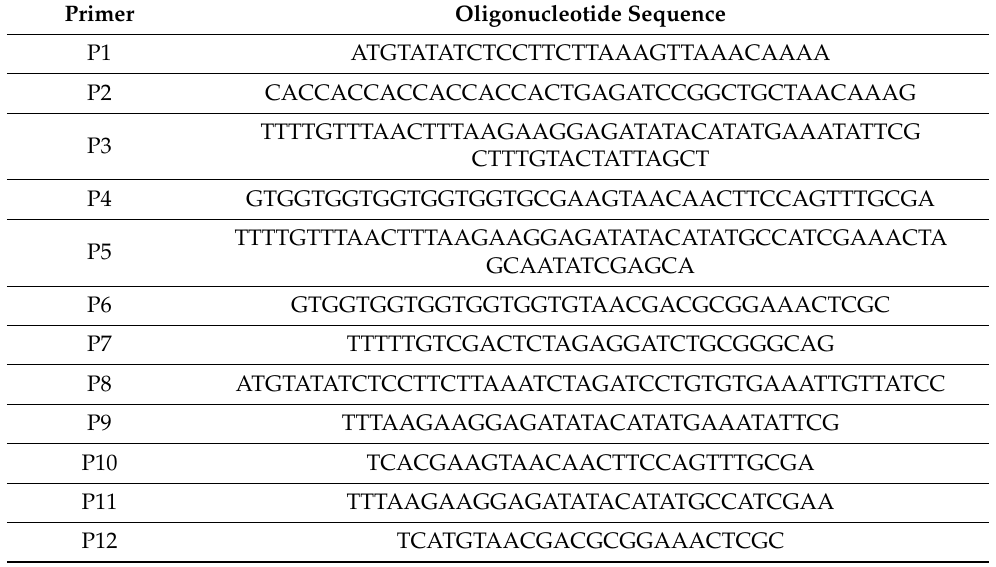
Table 2. Primers used in this